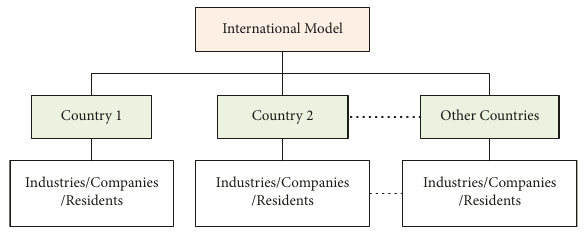
Figure 12: Framework of international model (source: Guangzhou Milestone Software Co., Ltd.,